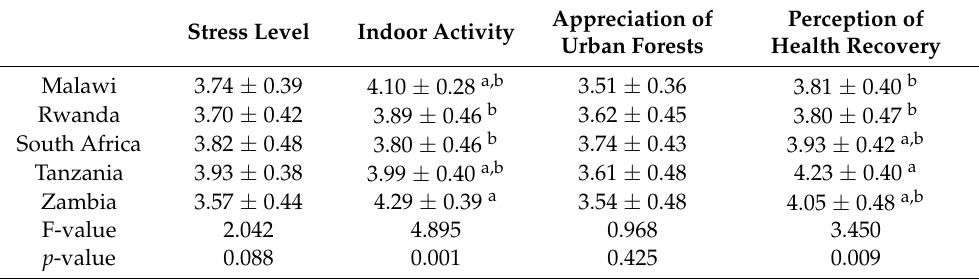
Table 5. Survey results overview: appreciation and perception of nature in five countries.